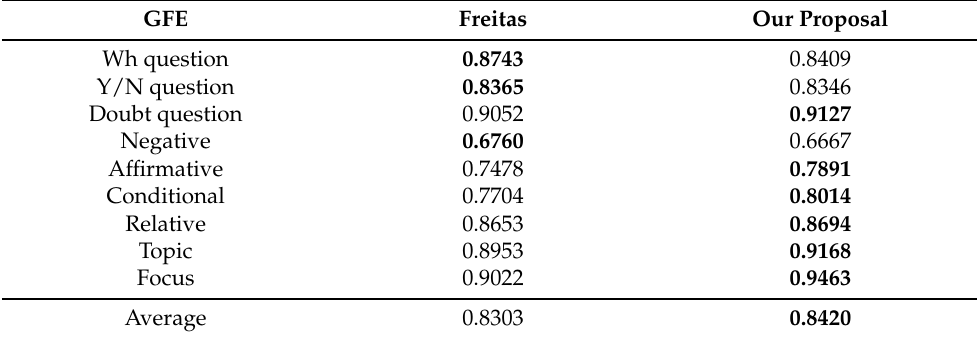
Table 8. F1 scores achieved by our proposed model and other state-of-art approaches that train a RFC with the Libras GFEs made by the subject one and test with the Libras GFEs of the subject two. Best results are in